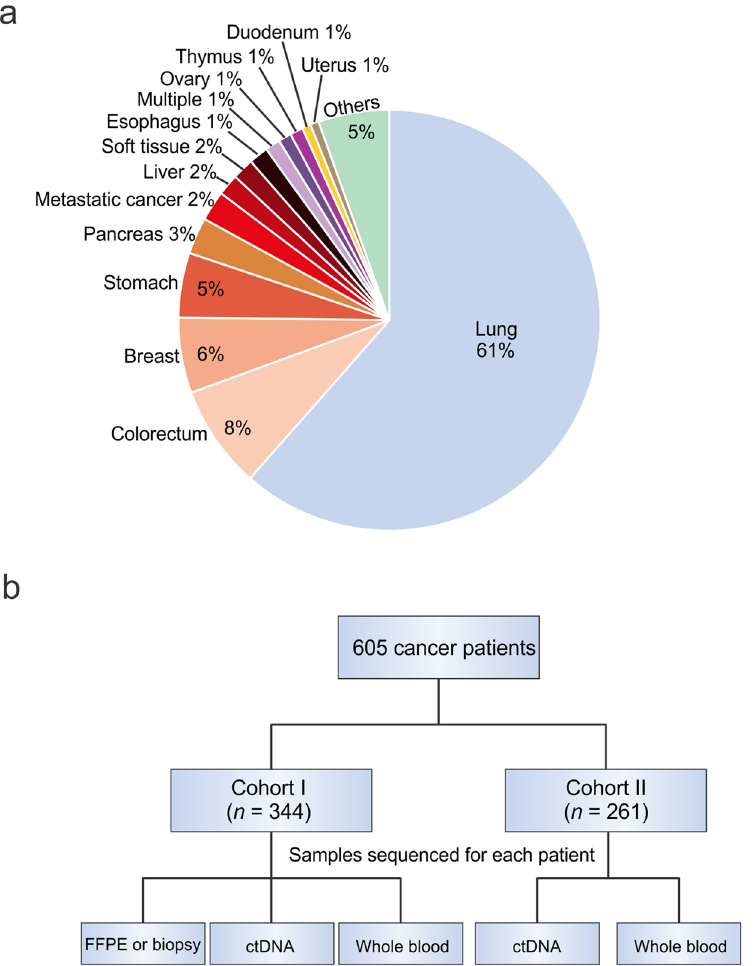
Figure 1. Study design and patient enrollment. ( a ) The percentage of different tumor types that enrolled in this study, including both Cohort I and II. Tumor types that were represented by less than 4 cases were classified as “Others”. ( b ) A schematic outlining our two-tiered study, including the cohorts and the specimens involved in this